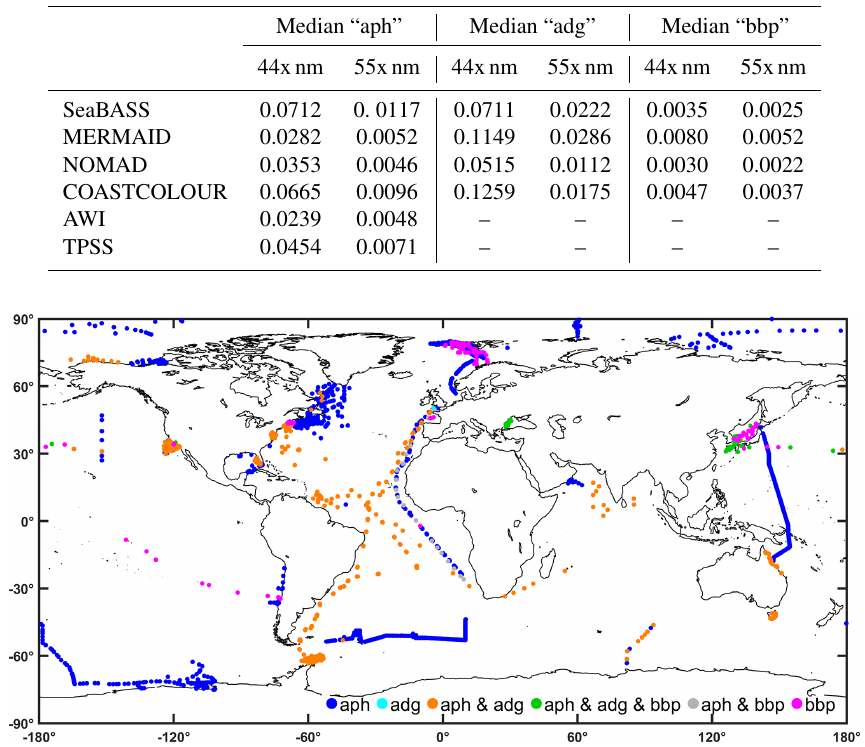
Figure 14. Global distribution of observations of inherent optical properties (algal pigment absorption coefficient “aph”, detrital plus CDOM absorption coefficient “adg”, and particle backscattering coefficient “bbp”) in the final